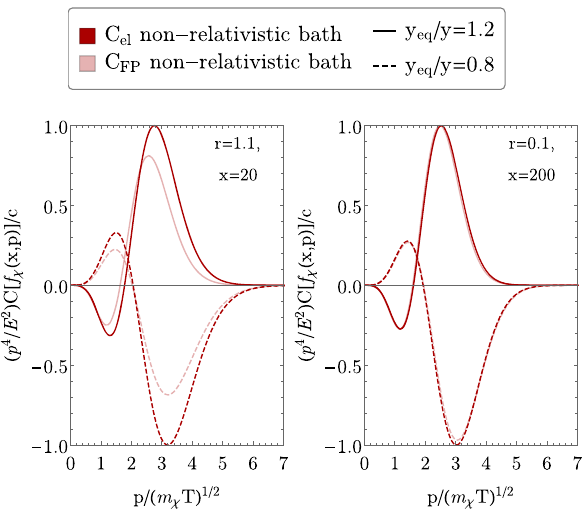
Fig. 9 The relative amplitude of the scattering collision term, as a function of the DM momentum p , for a constant scattering amplitude = const . ) and non-relativistic bath particles. As indicated ( | M | 2 χ f ↔ χ f in the legend, the various curves correspond to different versions of the collision terms, C FP or C el based on Eq. (B.2), as well as different temperature ratios y eq / y = T / T χ . Each curve is normalized to the (cid:7) (cid:8) p 4 / E 2 | C el , FP | same constant c = Max , where the maximum is taken over all lines of the respective plot